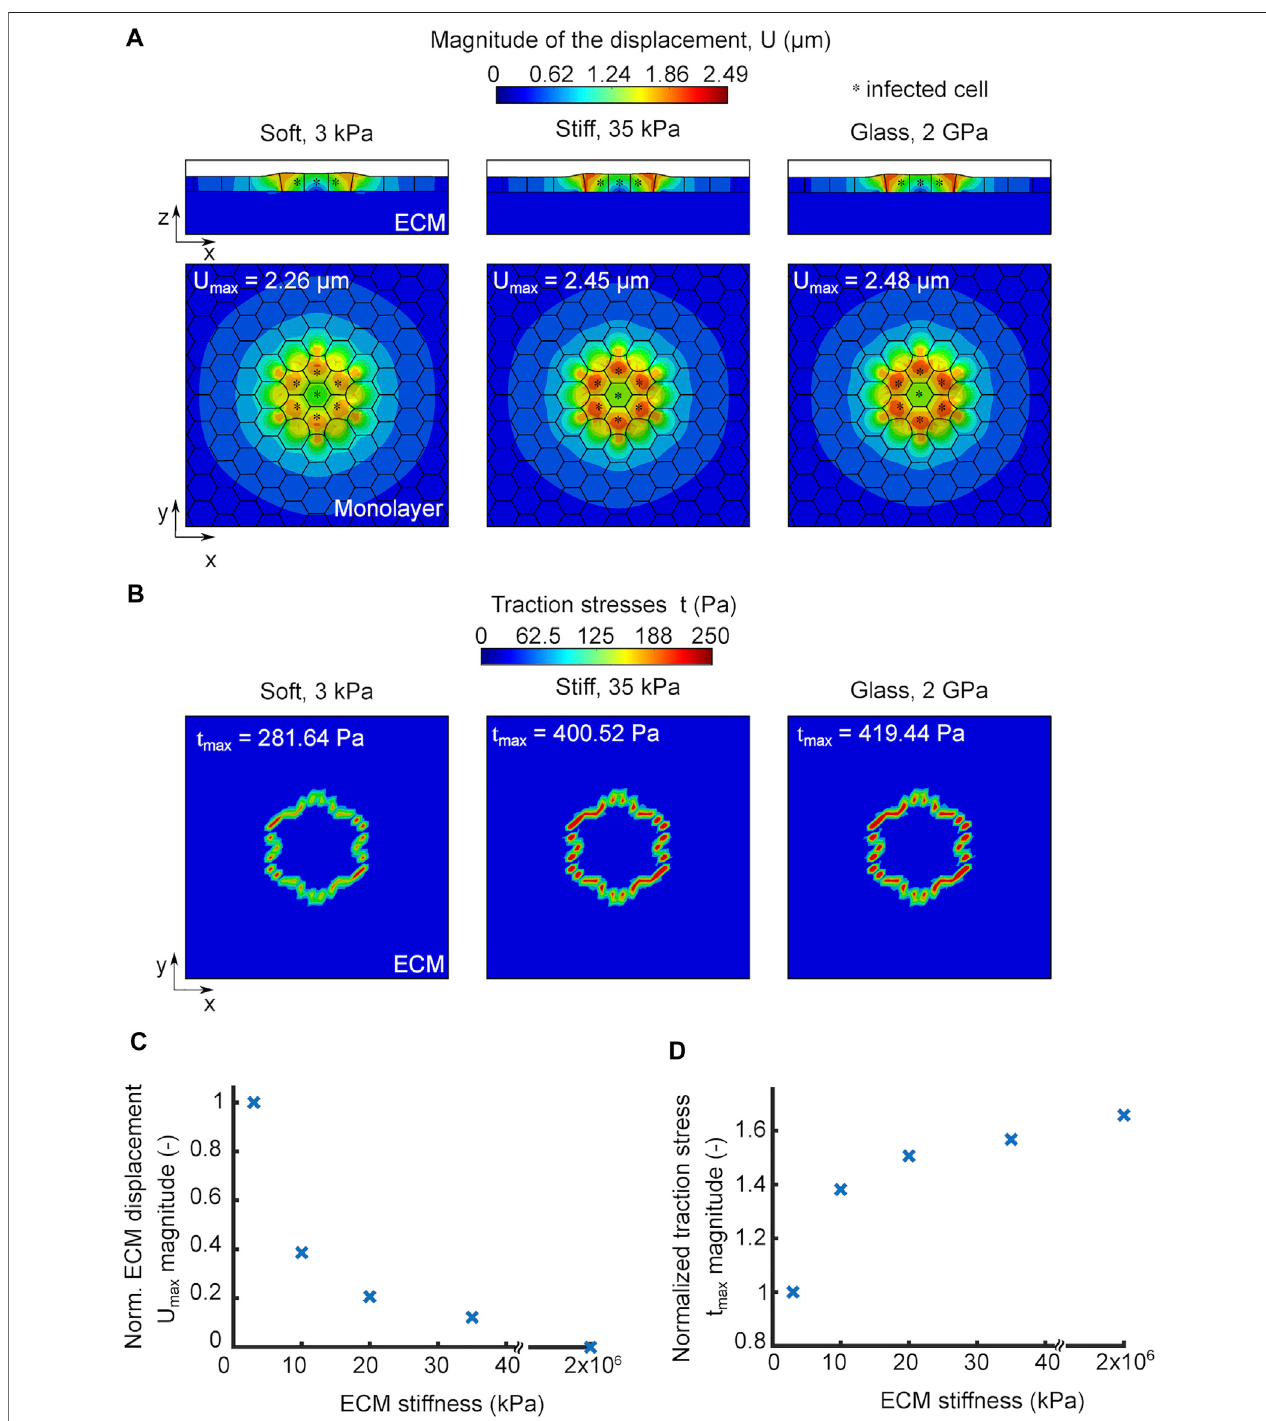
FIGURE4| Insilico modelpredictsthatincreasedECMstiffnesspromotesinfectedcellsqueezingbyenhancingcelldisplacementsandtractionstressesofnearby uninfected cells. (A) Orthogonal view maps of the magnitude of cellular displacements U ( μ m) of in silico infected cells residing on soft 3 kPa gel (left), stiff 35 kPa gel (middle) and 2 GPa glass substrate (right). Top (x – y) and side (x – z) views are shown in all three cases, and infected cells are denoted by an asterisk. An infection focus comprised by 7 cells is considered. The maximum cell displacement is indicated. (B) Orthogonal view maps of traction stresses exerted onto the ECM by the cells shown in panel A which have been exposed to in silico infection and reside on soft, stiff and glass matrices. The maximum traction stress is indicated. (C) Plot showing magnitude of maximum cell displacement ( U max , y -axis) versus ECM stiffness ( x -axis) for in silico cells in an infected monolayer. U max values are normalized relative to U max for cells residing on soft 3 kPa ECM. (D) Plot showing the magnitude of maximum traction stress ( t max , y -axis) versus ECM stiffness ( x -axis) for in silico cells in an infected monolayer. t max values are normalized relative to t max for cells residing on soft 3 kPa ECM. For C-D the infection focus consists of N = 7 infected cells.